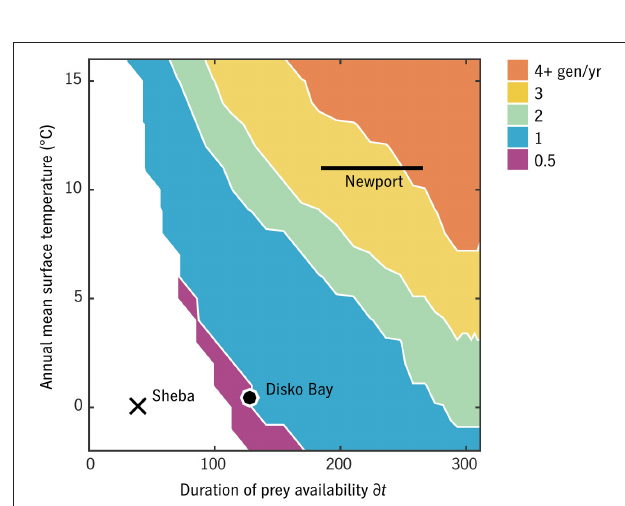
FIGURE 6 | Generations per year of the optimal strategy in each environmental combination for relative development rate u 0 = 0.007 d − 1 ( C. glacialis/marshallae analogs). Ice Station Sheba, Disko Bay, and Newport ( Figure 1 ) have been placed approximately for